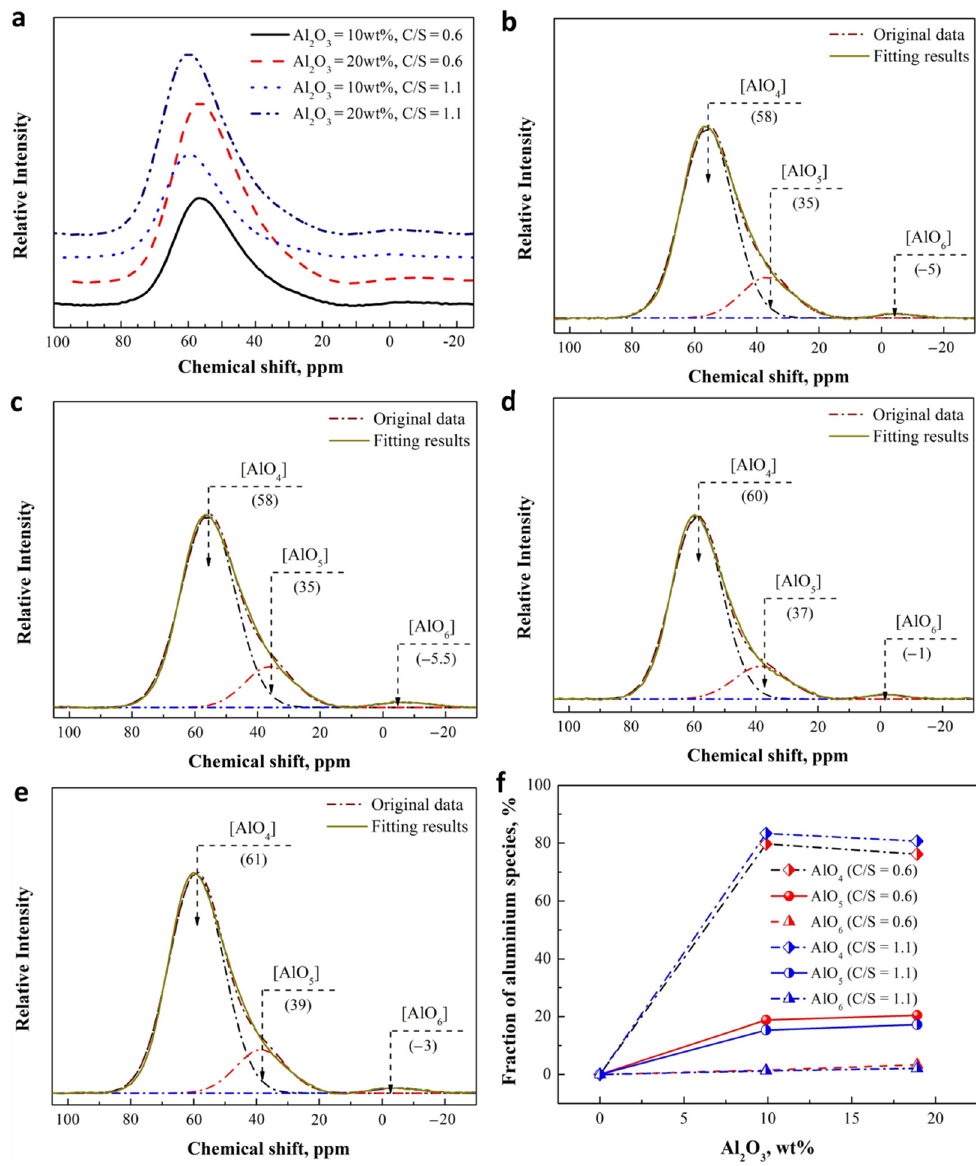
Figure 3. ( a ) 27 Al NMR MAS spectra of quenched CaO − SiO 2 − Al 2 O 3 slag at 1823 K as a function of Al 2 O 3 content and basicity, experimental 27 Al MAS NMR spectra (solid line), and fitting results (dashed lines with different colors) for CaO–SiO 2 –Al 2 O 3 slags with 9.93 wt% Al 2 O 3 and 0.6 of basicity ( b ); 18.97 wt% Al 2 O 3 and 0.6 of basicity ( c ); 9.4 wt% Al 2 O 3 and 1.1 of basicity ( d ); 18.9 wt% Al 2 O 3 and 1.1 of basicity ( e ). ( f ) Fraction of Al species as a function of basicity and Al 2 O 3 contents based on 27 Al MAS NMR of the CaO − SiO 2 − Al 2 O 3 slag.